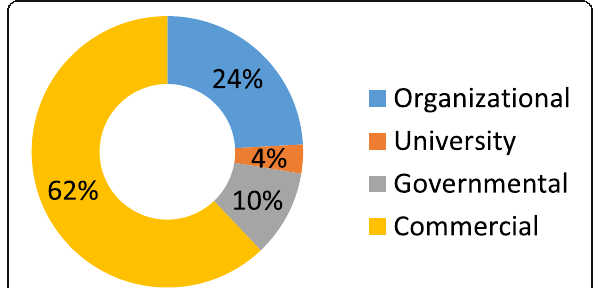
Fig. 2. Distribution of websites by organization